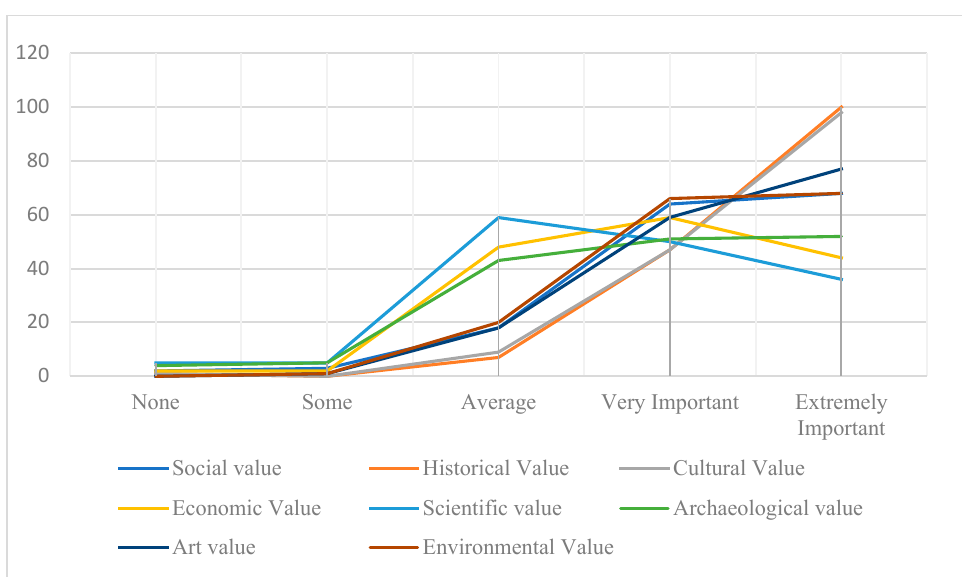
Figure 8. The values attributed to the Kulangsu cultural heritage set in the mind of the local.